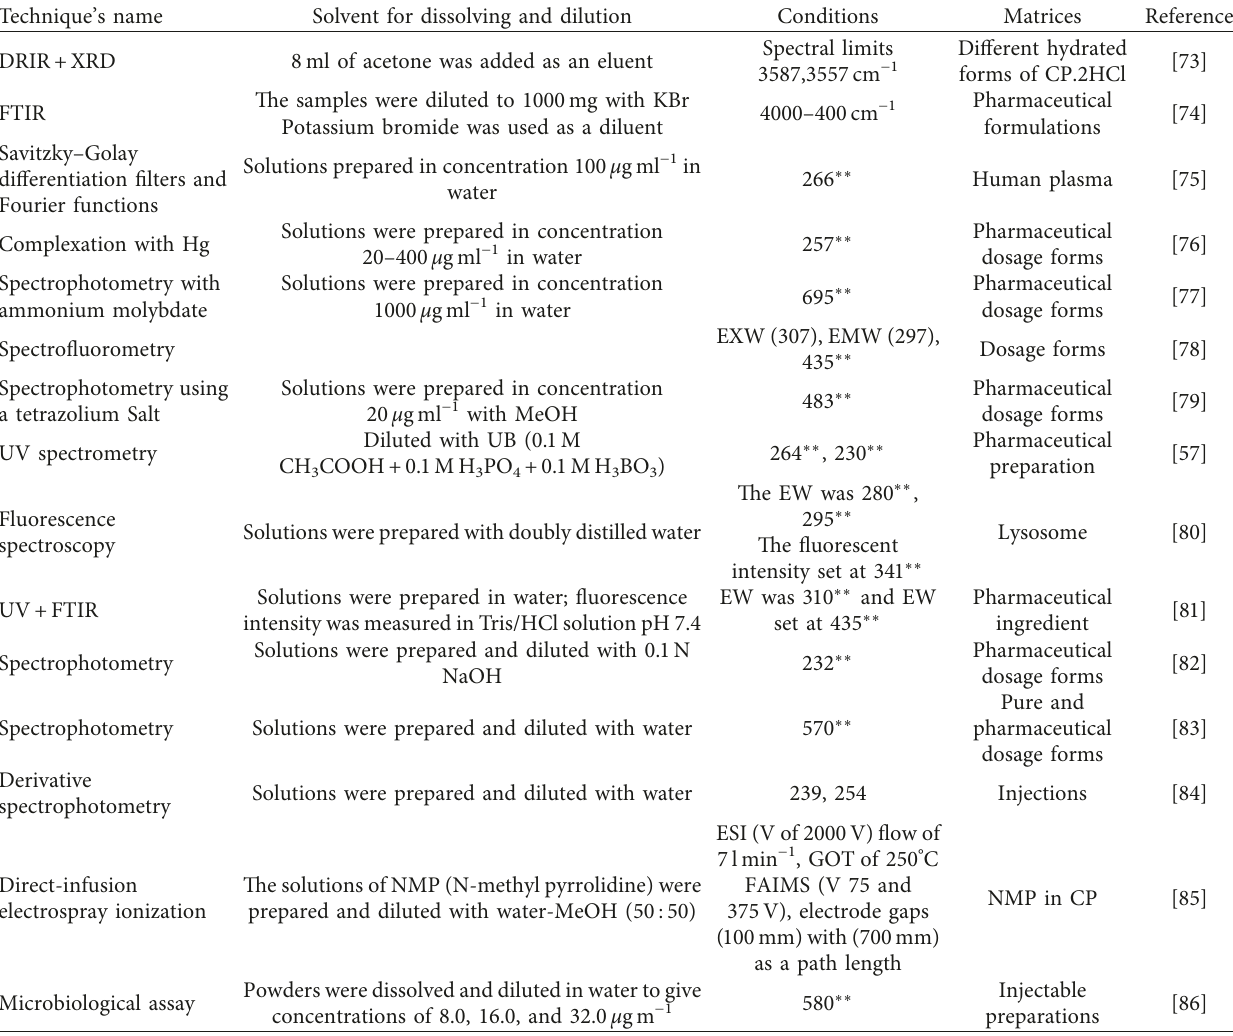
Table 5: Spectrophotometric methods for the analysis of CP.